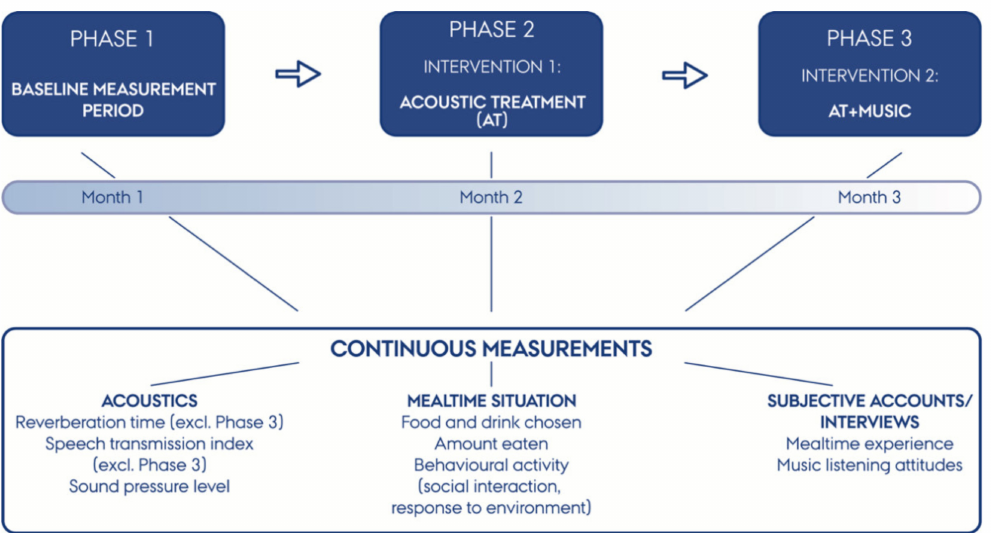
Figure 1. Experimental study design: project duration, intervention phases, and data measurement